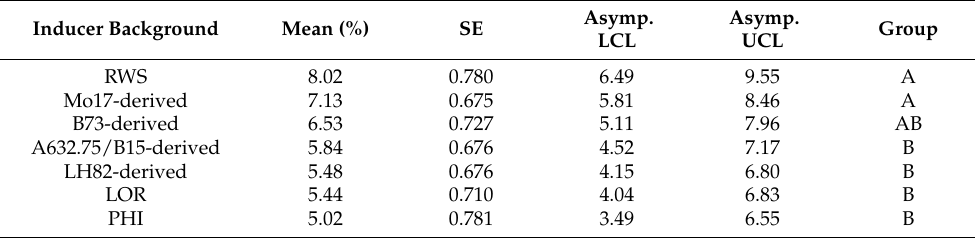
Table 3. Pairwise comparisons of the mean HIR in inducer